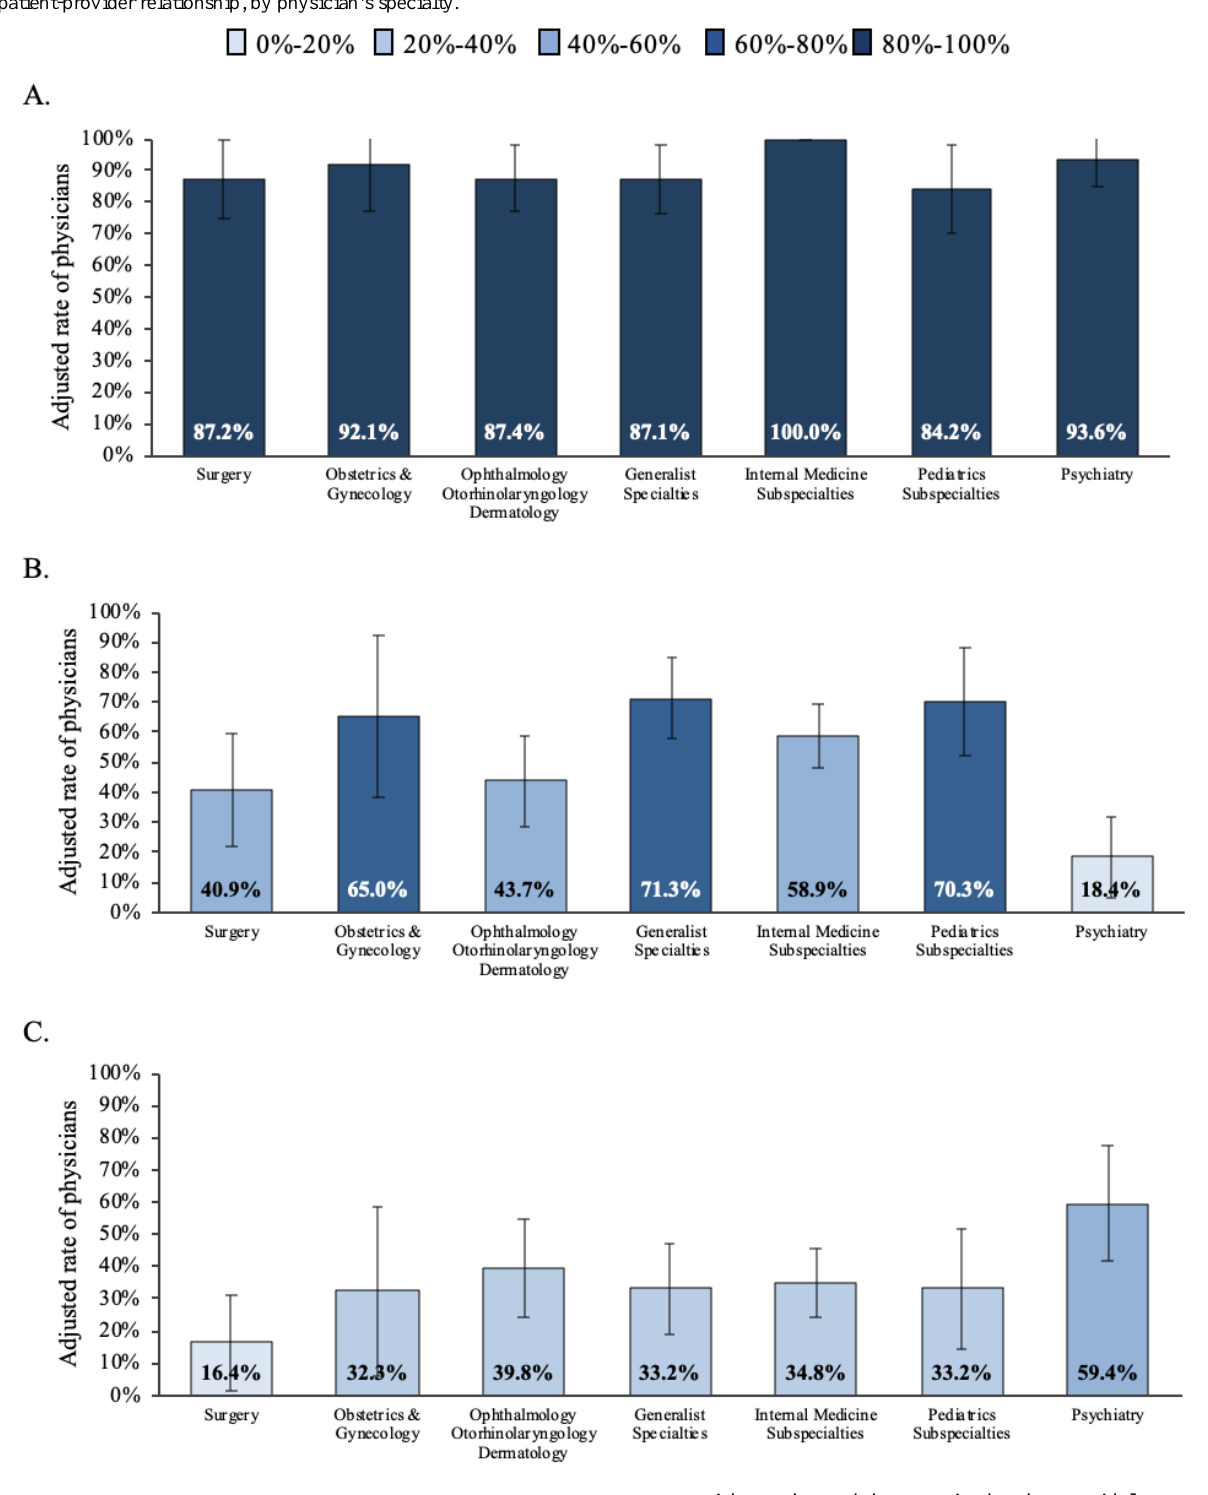
Figure 5. Adjusted rate and 95% CIs of providers reporting challenges with (A) the modality of service, (B) the patient’s diagnostic process, and (C) the patient-provider relationship, by physician’s